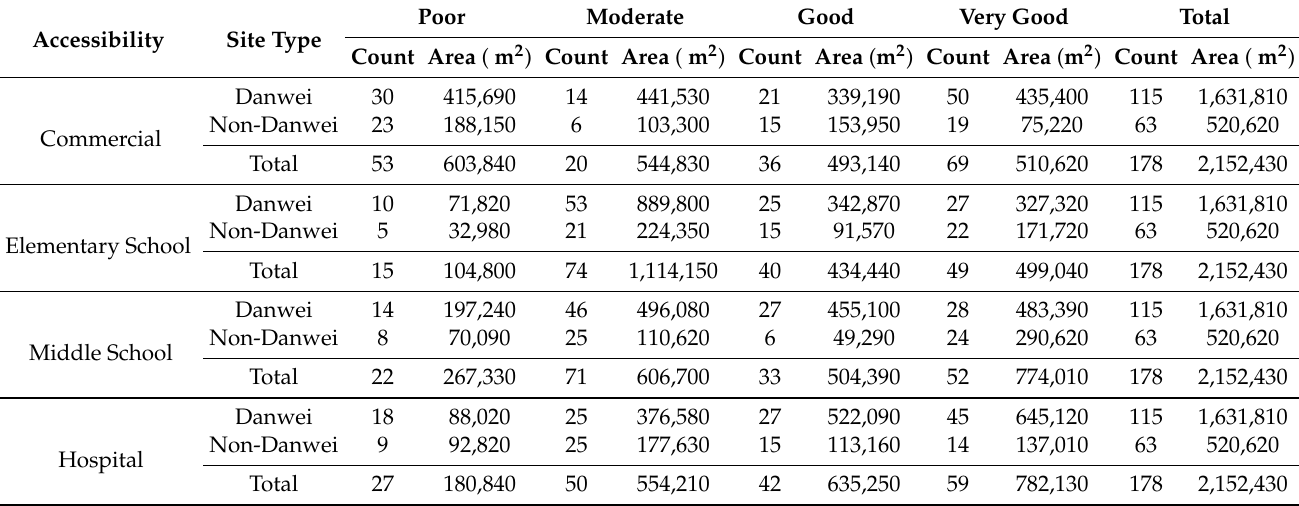
Table 4. The Number and total area Statistics by site types and accessibility to public facilities.